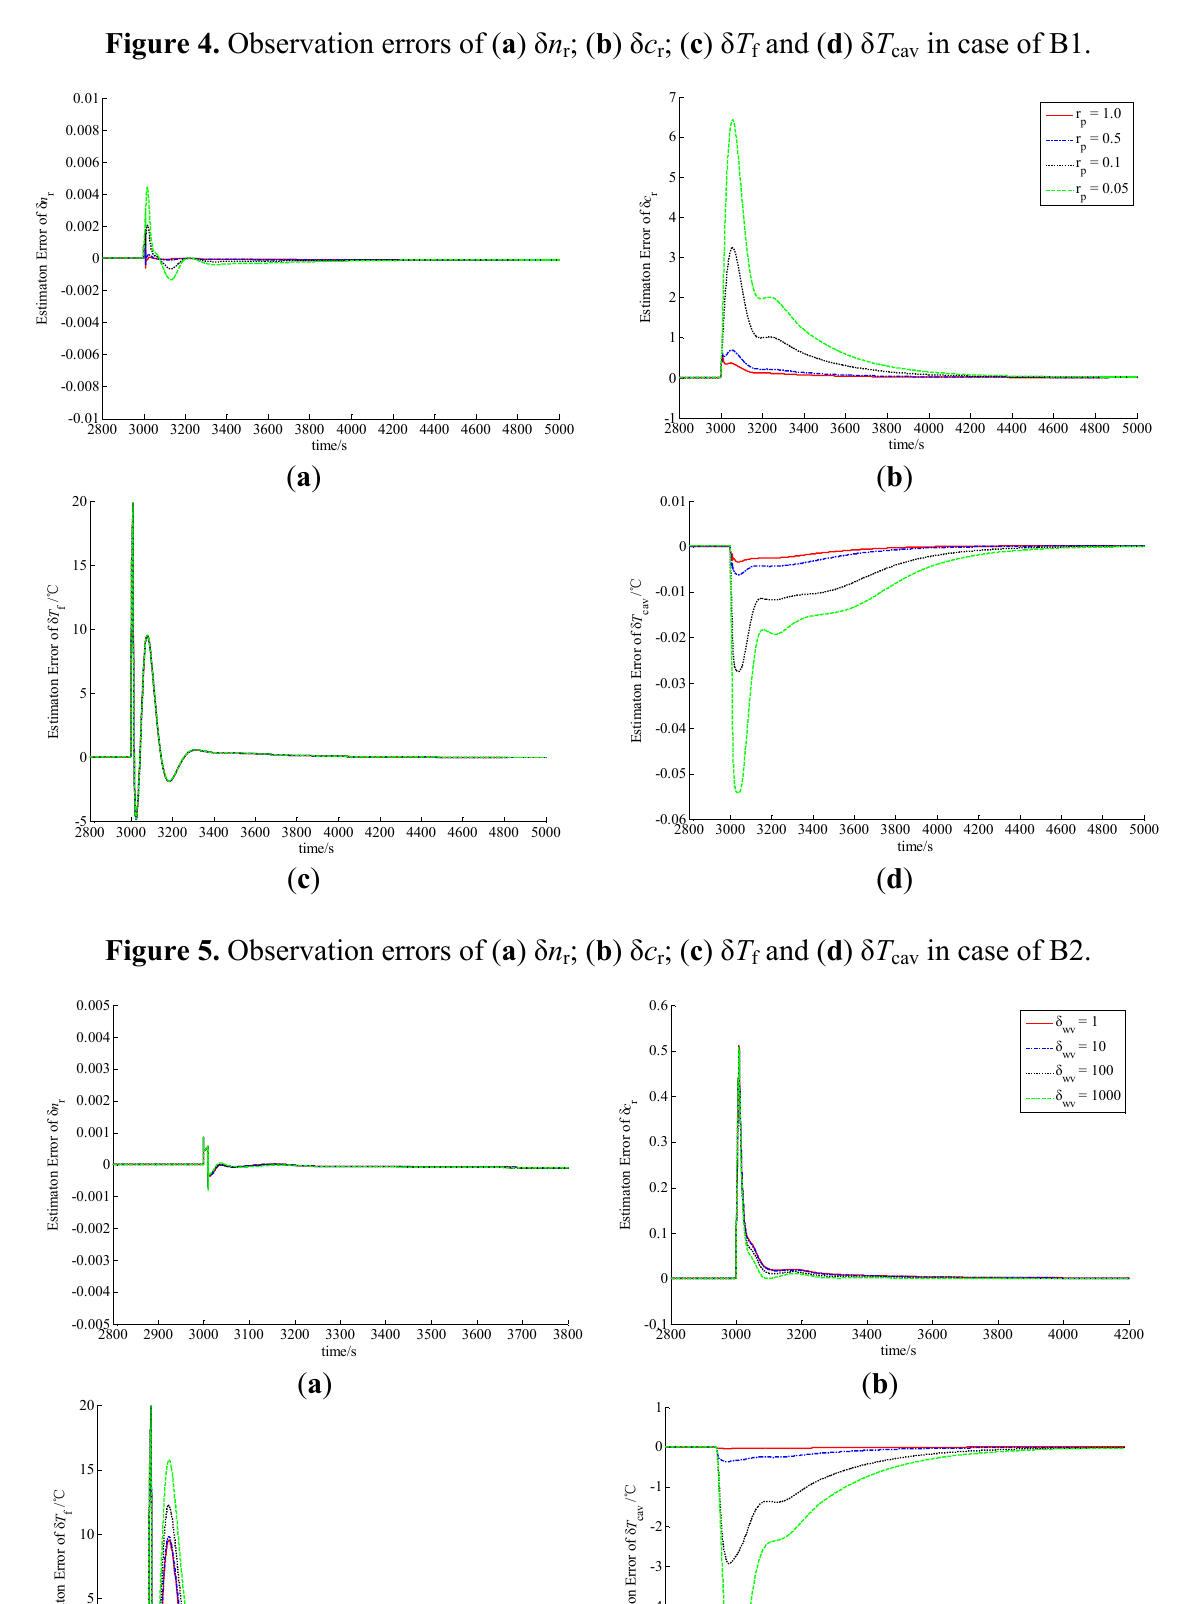
Figure 4. Observation errors of ( a ) δ n